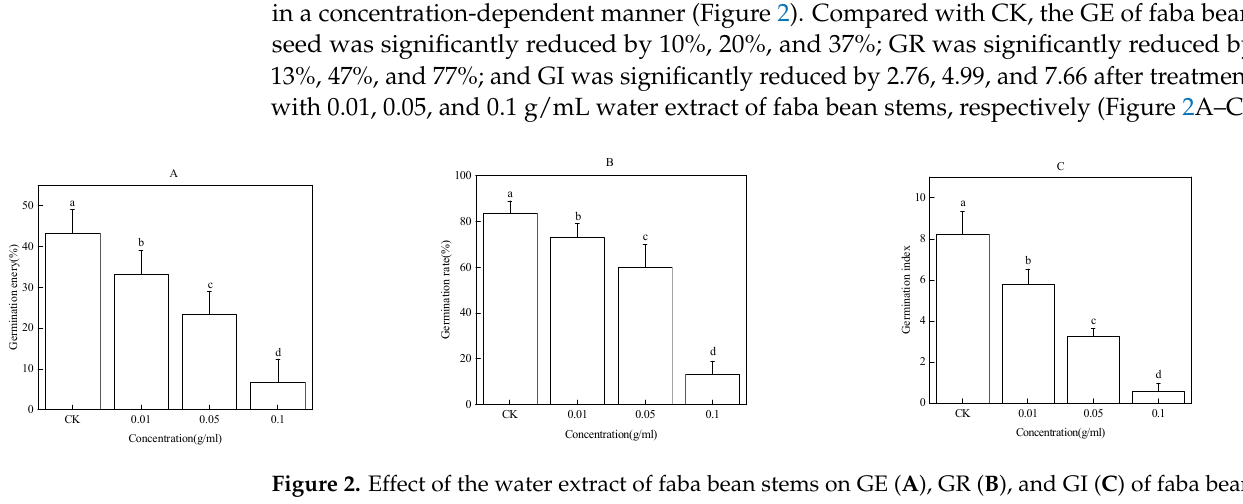
Figure 2. Effect of the water extract of faba bean stems on GE ( A ), GR ( B ), and GI ( C ) of faba bean seeds. Data are presented as the mean ± standard error of three biological replicates. Various letters for each index indicate significant differences at p < 0.05.